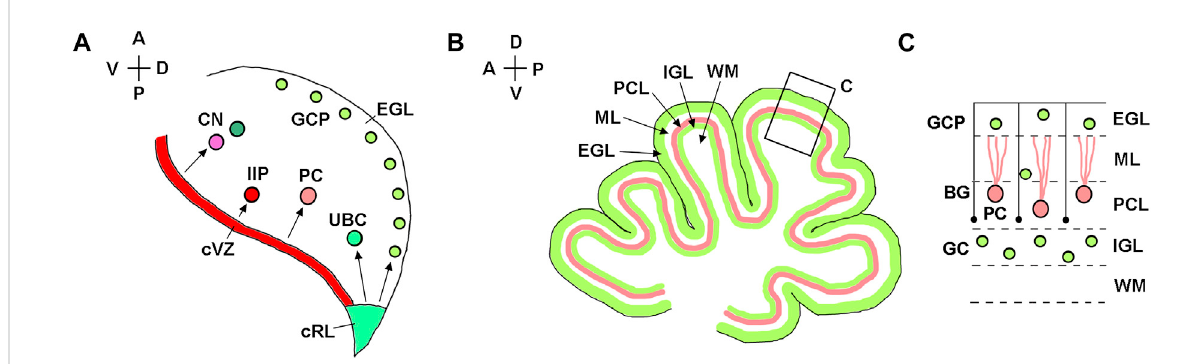
FIGURE 2 Developmental origin of major types of cerebellar neurons. (A) Diagram of a sagittal section of the mouse embryonic cerebellar anlage (e10.5- e18) showing that the cerebellar rhombic lip (cRL) gives rise to excitatory cerebellar cells, namely granule cell precursors (GCP), unipolar brush cells (UBC), and excitatory neurons of the cerebellar nuclei (CN). The cerebellar ventricular zone (cVZ) gives rise to inhibitory cells, such as Purkinje cells (PC),inhibitoryinterneuronprogenitors(IIP)andinhibitoryneuronsofCN.TangentiallymigratingGCPsformthesecondarygerminalzone — the external granule cell layer (EGL). (B) Diagram of a midsagittal section of the neonatal mouse cerebellum, showing layered organization of the cerebellar cortex. (C) Higher magni fi cation of the region boxed in panel (B) . After transient ampli fi cation in the EGL, GCPs differentiate into granule cells (GC) and migrate radially along Bergmannglial fi bers (shown as black lines) from the EGL to theIGL. External granule cell layer — EGL;Molecular layer — ML; Purkinje cell layer — PCL; internal granule layer — IGL; white matter — WM. The anterior-posterior (A – P) and dorsal-ventral (D – V) axes are shown in the top left corner of panels (A) and (B)